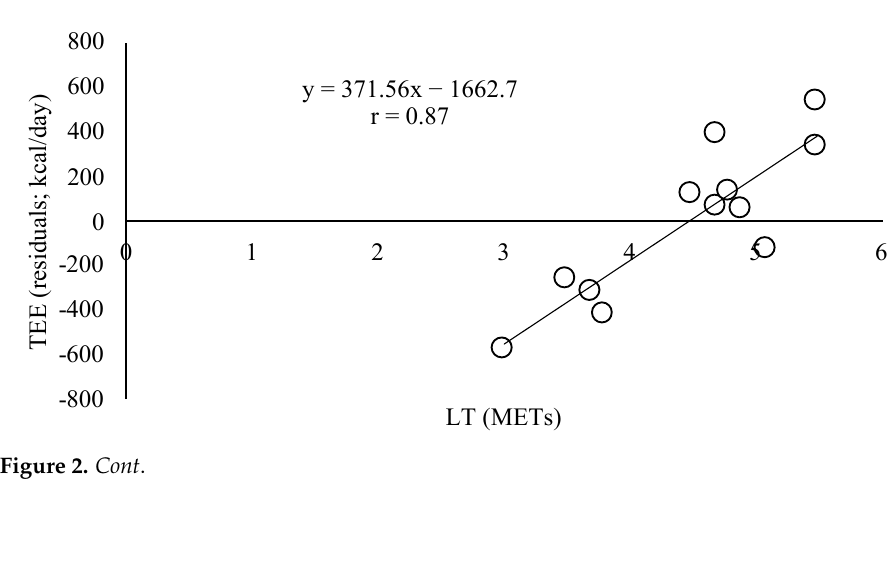
Figure 2. Relationship between LT and the residuals adjusted for TEE by body mass ( A ); LT and the residuals adjusted for TEE by FFM ( B ). 4. Discussion We measured LT as aerobic capacity and TEE, AEE, and PAL using the DLW method in adults of advanced old age (80–94 years old) in rural communities. We found that the aerobic capacity of LT was positively and independently correlated with TEE, AEE, and PAL. Longevity and healthy life spans are increasing in our society [33], and it is necessary to conduct research to determine the energy requirement for healthy and independent older people aged >80 years. However, there is little data on the TEE of advanced older people over 80 years old, assessed by the objective method of PAL and other physical abilities. The reduction of physical fitness, including muscular strength and physical function, and a decline in physical activity are thought to be factors in frailty [1]. We objectively assessed aerobic capacity using MET at LT because low LT is related to exhaustion of the frailty cycle in daily physical activity. The reduction of TEE and PAL is also considered a key factor in the frailty cycle [2]; however, few studies have examined the relationship between TEE and aerobic capacity in adults of advanced old age. Our data objectively support the frailty cycle concept. The present results could indicate that aerobic capacity is important for preventing